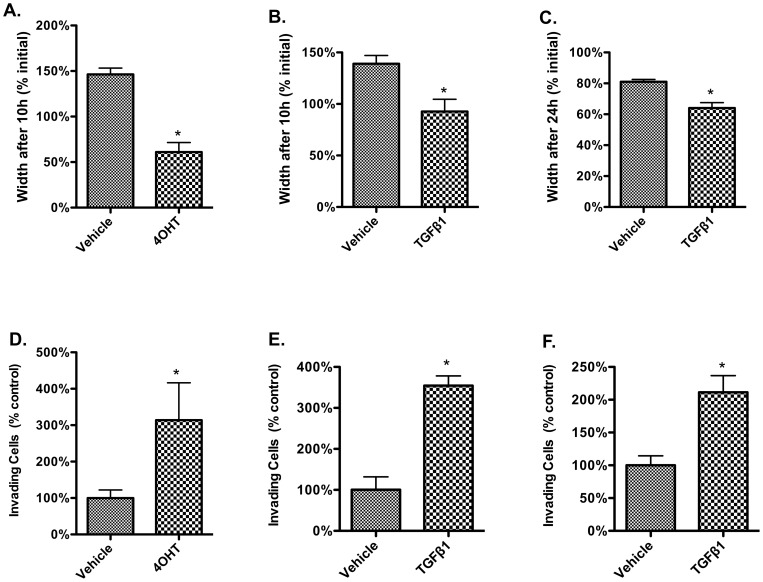
Functional increase in migration and invasion following treatment to induce EMT in three cell-based models of breast cancer.Changes in cell behavior were seen by Day 4 in HMLE Twist ER cells and by Day 2 in MCF-7 cells. Top panels: Migration assayed by scratch-wound assay. Bottom panels: Invasion in a modified Boyden-chamber invasion assay. A. Closure of a scratch wound after 10 h in vehicle control versus HMLE Twist ER cells treated with 4OHT (induced Twist model). B. Closure of a scratch wound after 10h in vehicle control versus HMLE Twist ER cells treated with TGF-β1. C. Closure of a scratch wound after 24 h in vehicle control versus MCF-7 cells treated with TGF-β1. Due to inherent differences in cell biology, the rate of migration was faster for HMLE Twist ER cells treated with 4OHT or TGF-β1 than for MCF-7 cells treated with TGF-β1. MCF-7 migration was barely detectable at 10h after wounding but was marked for TGF-β1-treated cells at 24 h. At 24 h HMLE Twist ER TGF-β1 wounds were nearly closed and HMLE Twist ER 4OHT wounds were completely closed while vehicle-control wounds remained prominent. A loss of epithelial integrity is also reflected in the apparent increase in width of the vehicle-control wounds in this assay. Upon “wounding” the confluent epithelial sheet with a pipette tip, cells induced to undergo EMT were lifted from the plate and dispersed (medium was subsequently changed to prevent re-seeding within the wound). In contrast, vehicle-control treated cells lifted from the plate by wounding remained firmly attached to their fellows, resulting in partial delamination of the epithelial sheet. Throughout the course of the assay the delaminated cells eventually became separated from the cells still adhering to the plate and floated to the surface. In some cultures the loss of the delaminated portion resulted in an apparent increase in the diameter of the scratch wound observed over the assay period, because the initial wound diameter had been partially obscured by the delaminated portion. D. Invasion of vehicle control versus HMLE Twist ER cells treated with 4OHT. E. Invasion of vehicle control versus HMLE Twist ER cells treated with TGF-β1. F. Invasion of vehicle control versus MCF-7cells treated with TGF-β1. * indicates significantly different from vehicle with p<0.05. Error bars indicate standard error of the mean.